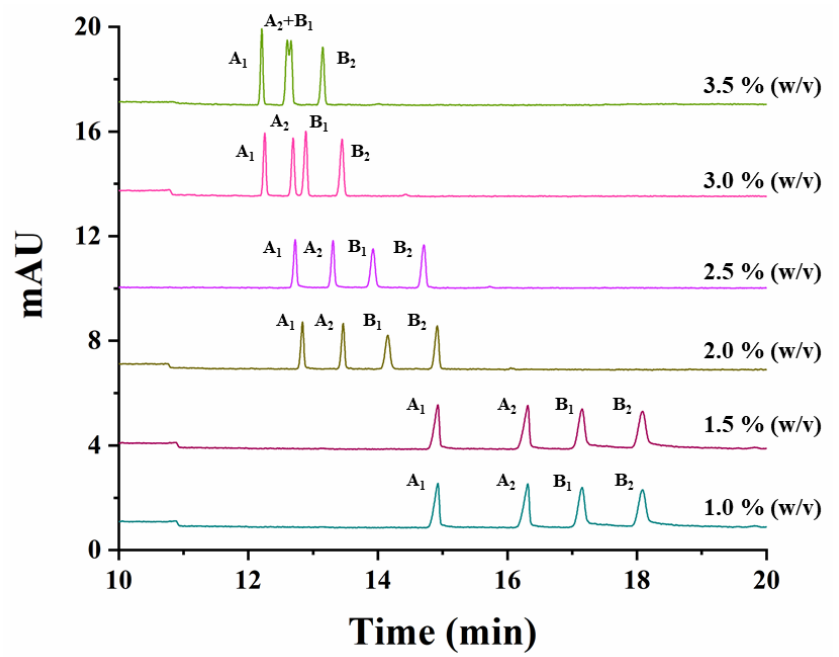
Figure 2. Electropherograms showing the effect of captisol concentration on the simultaneous separation of carfentrazone-ethyl and carfentrazone enantiomers using a standard solution containing 30 mg L − 1 carfentrazone-ethyl racemate and 20 mg L − 1 carfentrazone racemate with a 100 mM sodium acetate buffer (pH 5.0). Experimental conditions: uncoated fused-silica capillary, 58.5 cm (50 cm effective length × 50 µ m i.d.); hydrodynamic injection: 50 mbar × 10 s; temperature: 20 °C; voltage: − 20 kV; λ : 245 nm ± 4 nm. A 1 and A 2 : carfentrazone-ethyl enantiomers. B 1 and B 2 : carfentrazone enantiomers.